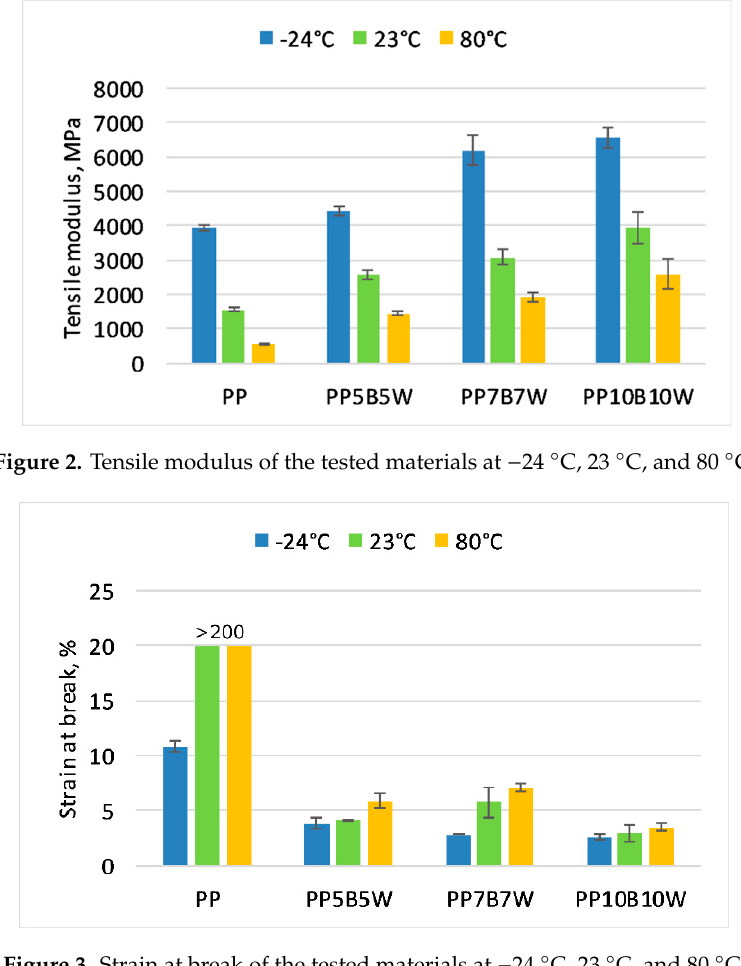
− 24 ◦ C, 23 ◦ C, and 80 ◦ Figure 3. Strain at break of the tested materials at − 24 °C, 23 °C, and 80 °C. Figure 3. Strain at break of the tested materials at Figure 3. Strain at break of the tested materials at − 24 °C, 23 °C, and 80 °C. Figure 3. Strain at break of the tested materials at − 24 °C, 23 °C, and 80 °C.